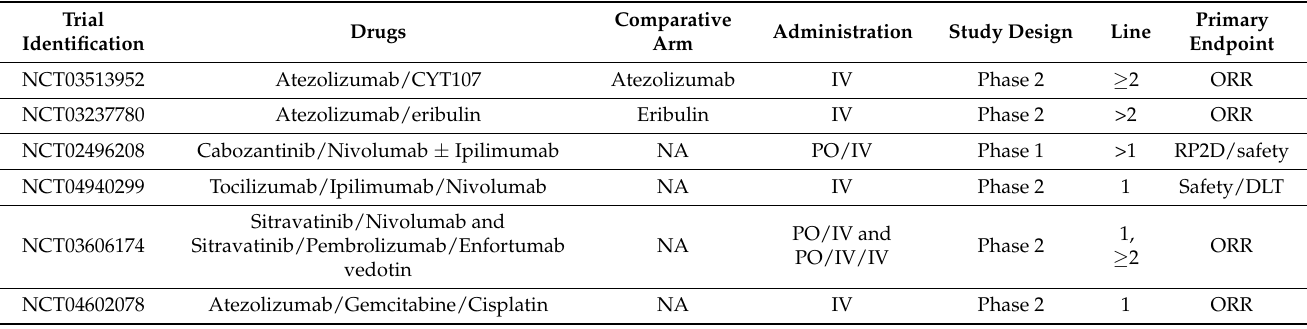
Table 3. Ongoing trials assessing immune checkpoint inhibitors-based combinations therapies in the metastatic setting. Trial